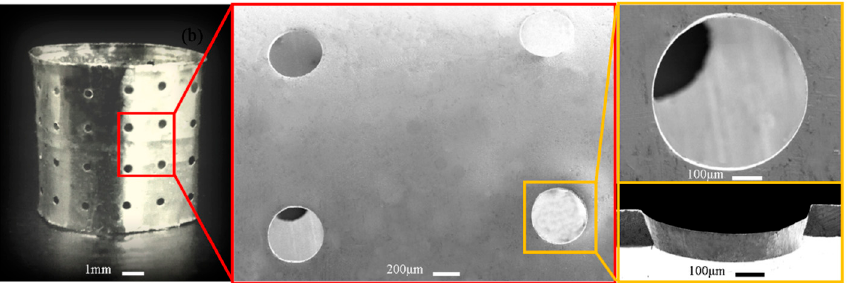
Figure 11. Electroformed seamless perforated hollow cylinder with unidirectionally tapered perforations. Micromachines 2020 , 11 , x